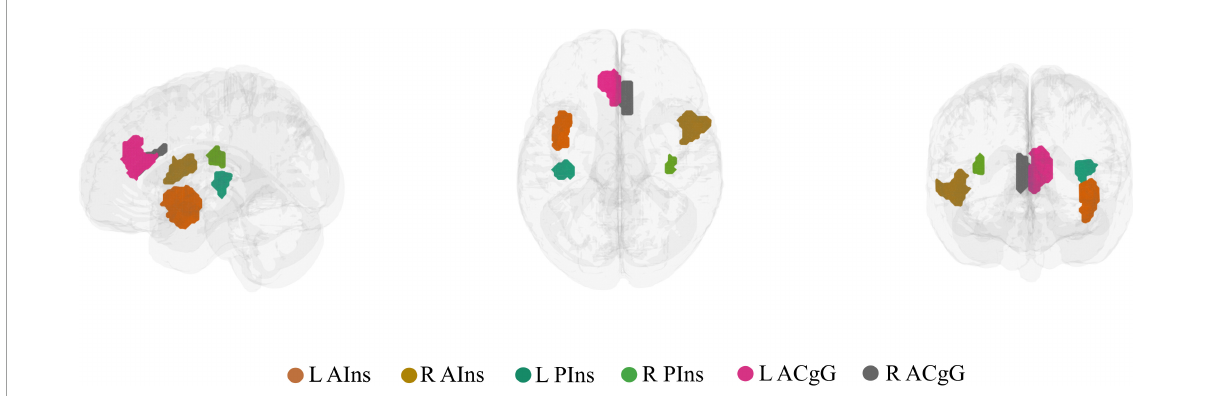
FIGURE2 The six brain nodes selected to represent key chronic pain brain regions shown in a lateral, superior, and anterior brain view. L AIns, left anterior insula; R AIns, right anterior insula; L PIns, left posterior insula; R PIns, right posterior insula; L ACgG, left anterior cingulate gyrus; R ACgG, right anterior cingulate